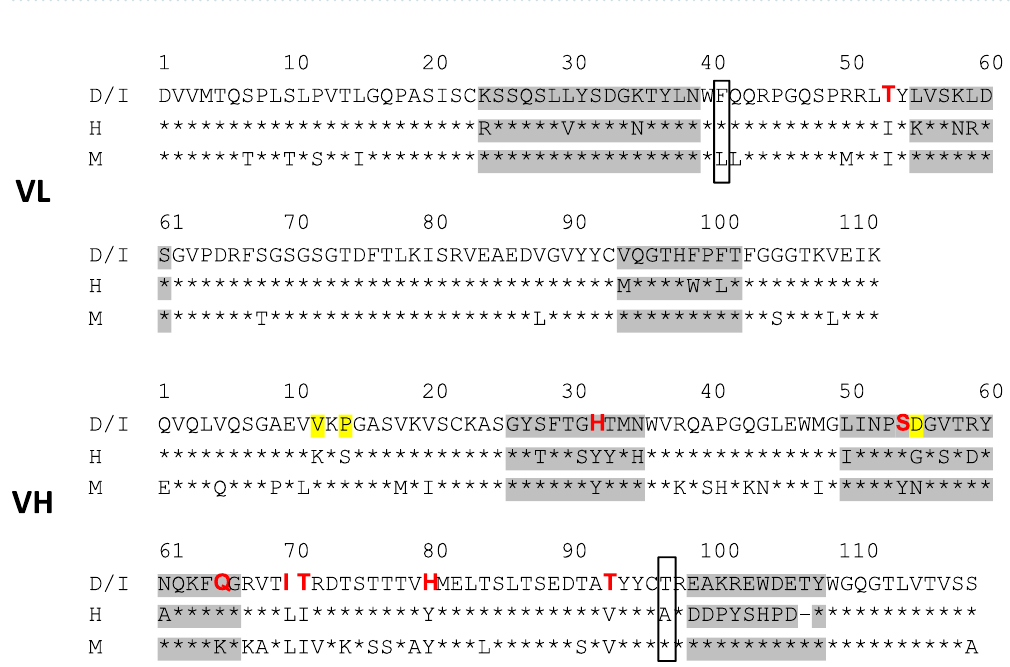
Figure 3. PBD-C06 sequences of VL and VH chains. Amino acid sequence including CDRs (grey), de- immunized amino acids (red) and substitutions for protein stability (yellow). D/I represents the de-immunized sequence of PBD-C06 and H and M are the human IGHV1-3 * 01 and murine hybridoma precursor sequences, respectively. Boxes indicate two framework regions potentially involved in antigen